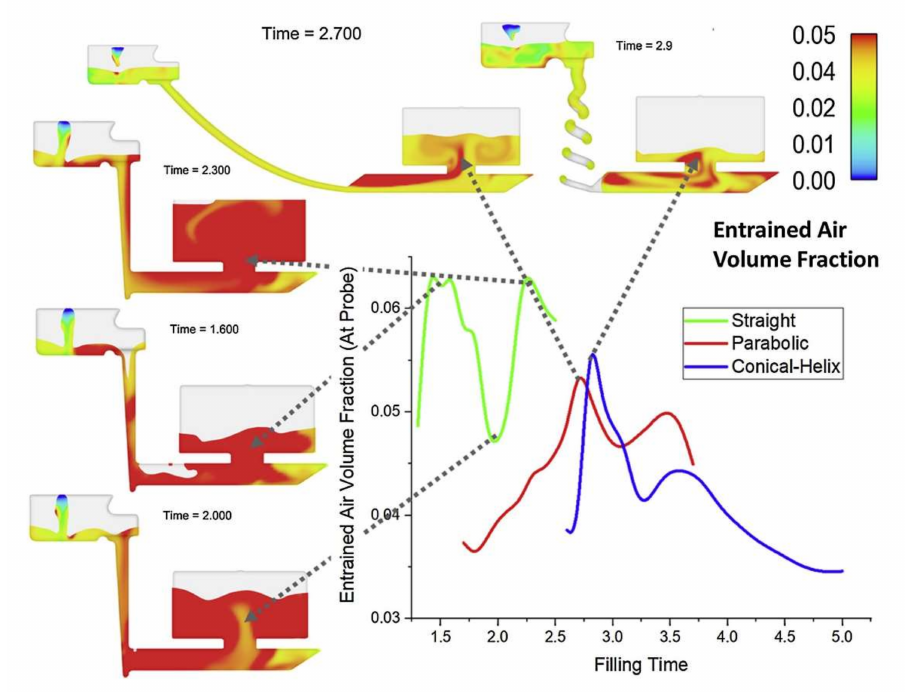
Figure 6. Comparison of air entrained by straight, parabolically inclined, and conical helix sprues